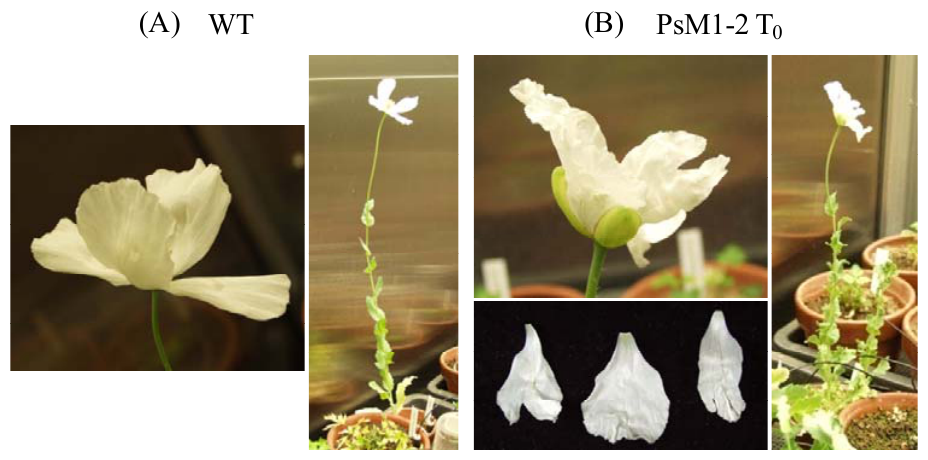
primary mutant and WT P. somniferum 0 . Upper left: flower; right: grown 0 only). 0